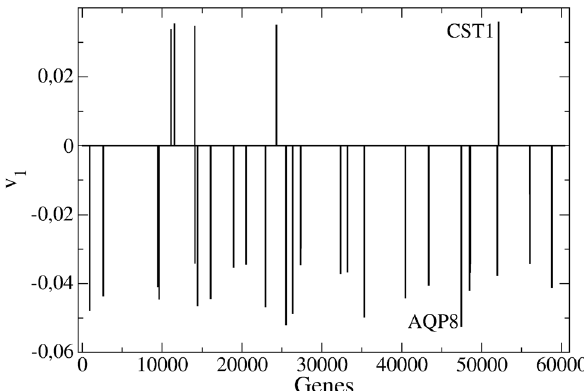
Figure 2. The 30 genes with most significant contributions to the v 1 vector in COAD. The x axis is the sequence number of a given gene in the TCGA data. CST1 is highlighted among the over-expressed and AQP8 among the silenced